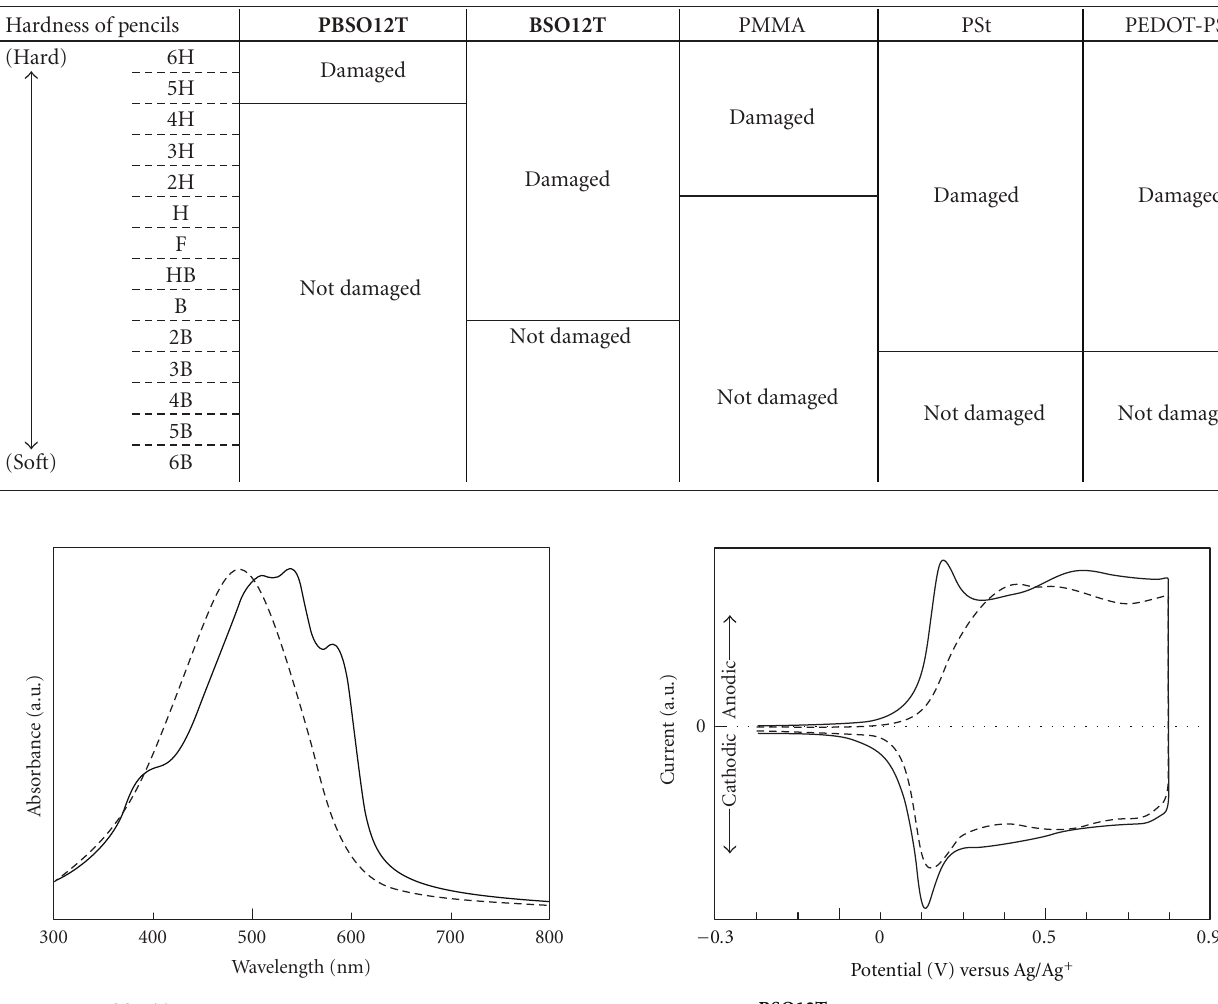
Table 2: Results of pencil hardness test for PBSO12T , BSO12T , PMMA, PSt, and PEDOT-PSS. Hardness of pencils